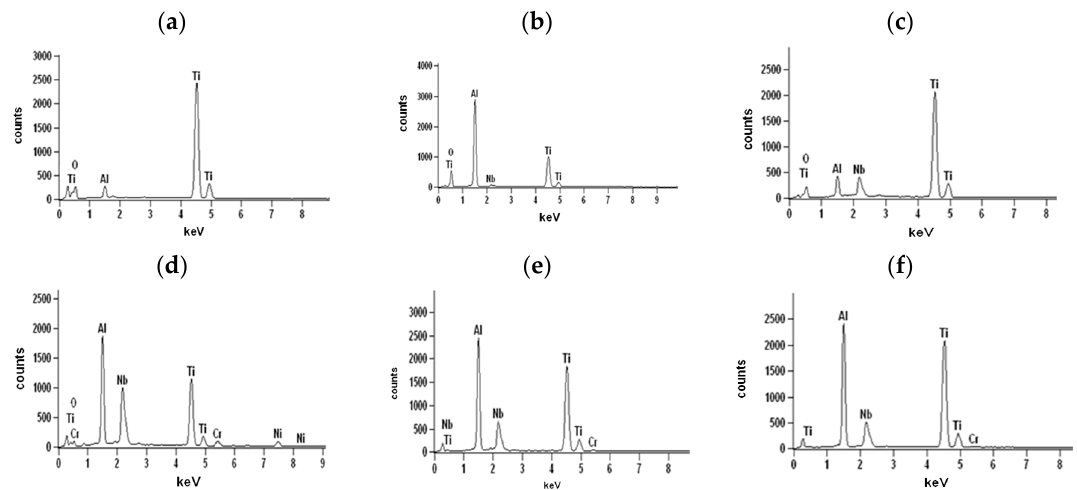
Figure 16. EDS analysis: ( a ) in point 1, ( b ) in point 2, ( c ) in point 3, ( d ) in point 4, ( e ) in point 5 and ( f ) in point 6 marked in Figure 15.